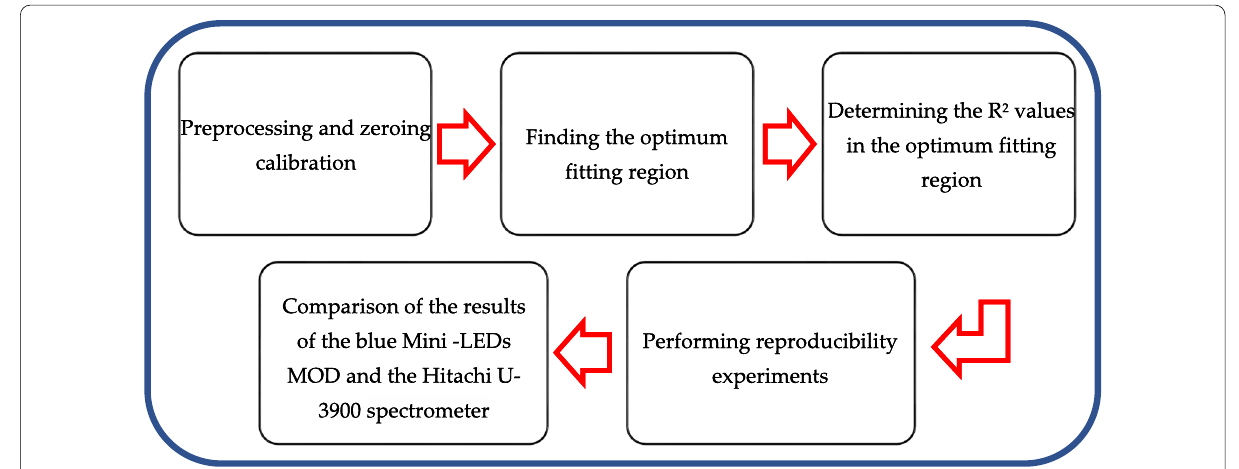
Fig. 3 Schematic diagram of the experimental process